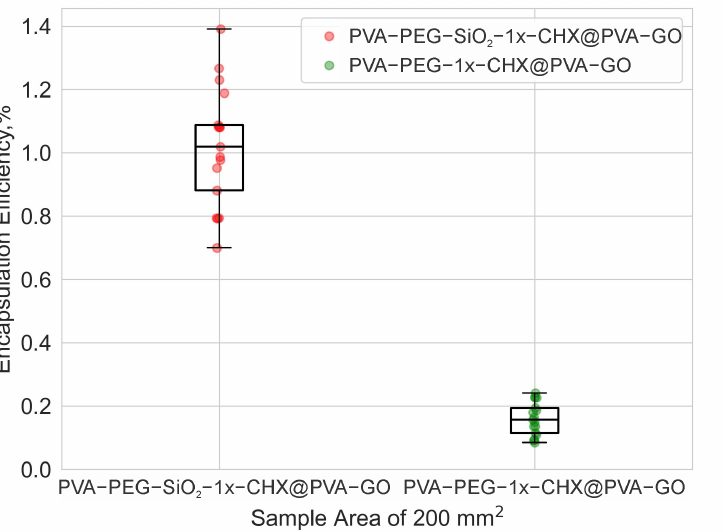
Figure 8. Encapsulation efficiency of drug for PVA-PEG-1x-CHX@PVA-GO, PVA-PEG-SiO 2 -1x-